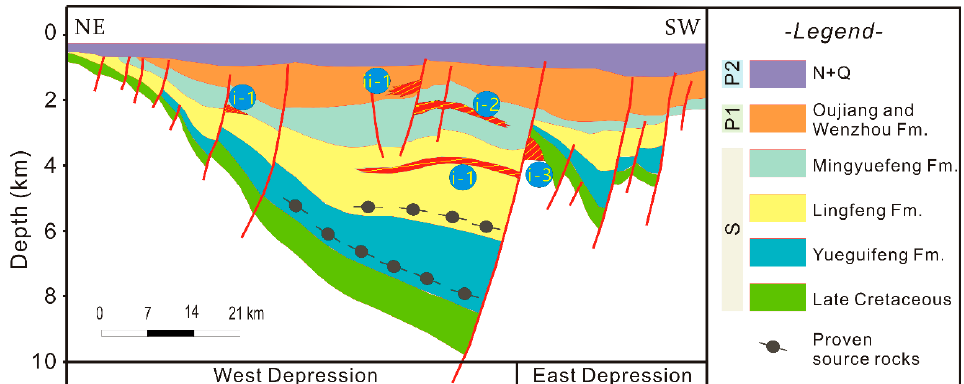
Figure 12. Schematic geological cross-section of the Lishui Sub-basin, and its proven and speculative plays. Note that all belong to the Yueguifeng–Lingfeng Petroleum System (!). Line location is indicated in Figure 11. All the red lines are normal faults; S = syn-rift; P1 = early post-rift; P2 = late post-rift; i-1 = Lingfeng structural (proven); i-2 = Mingyuefeng structural (proven); i-3 = Basement structural–stratigraphic (proven); ii-1 = Oujiang structural (speculative).